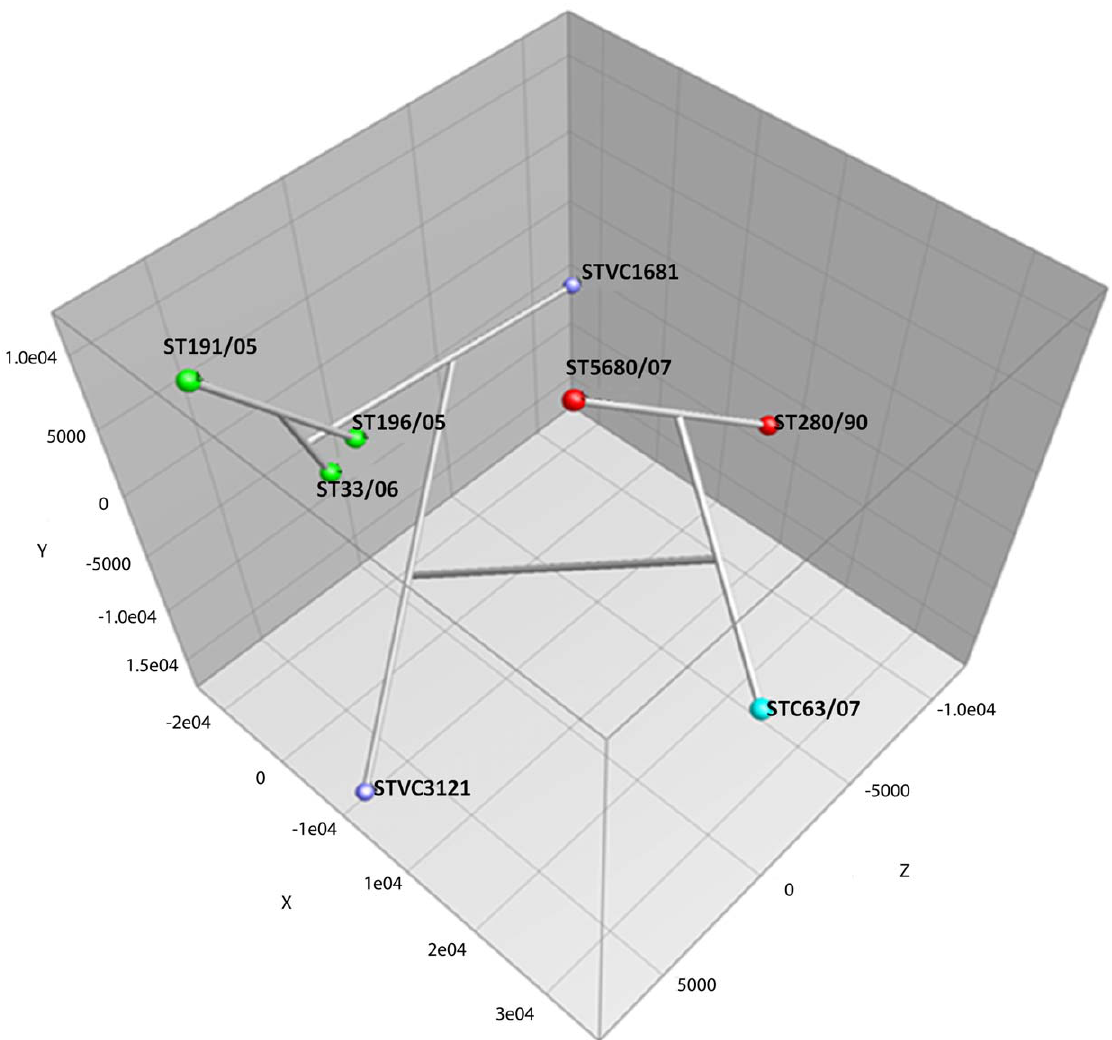
Figure 2. Three-dimensional principle component analysis (PCA) of eight Salmonella enterica serovar Typhi strains. A three- dimensional principle component analysis (PCA) of the eight S. Typhi strains was calculated from the corrected average area under the bacterial growth curve. For each carbon well, the average area under the bacterial growth curve was corrected to zero if the T max –T min value was lesser than the threshold value of 50.